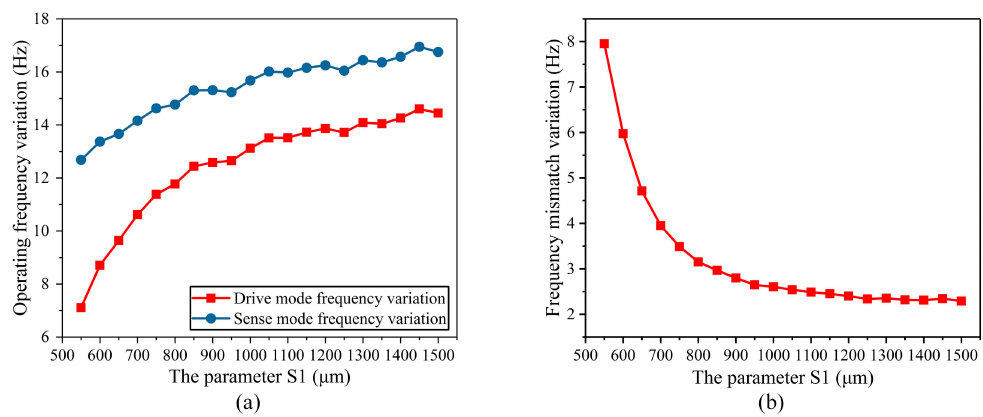
Figure 6. The parameter of the height of the stress-released structure (S 1 ) affected the variation of the operating frequency and frequency mismatch: ( a ) The degree of variation of the operating frequency; ( b ) the degree of variation of the frequency mismatch.